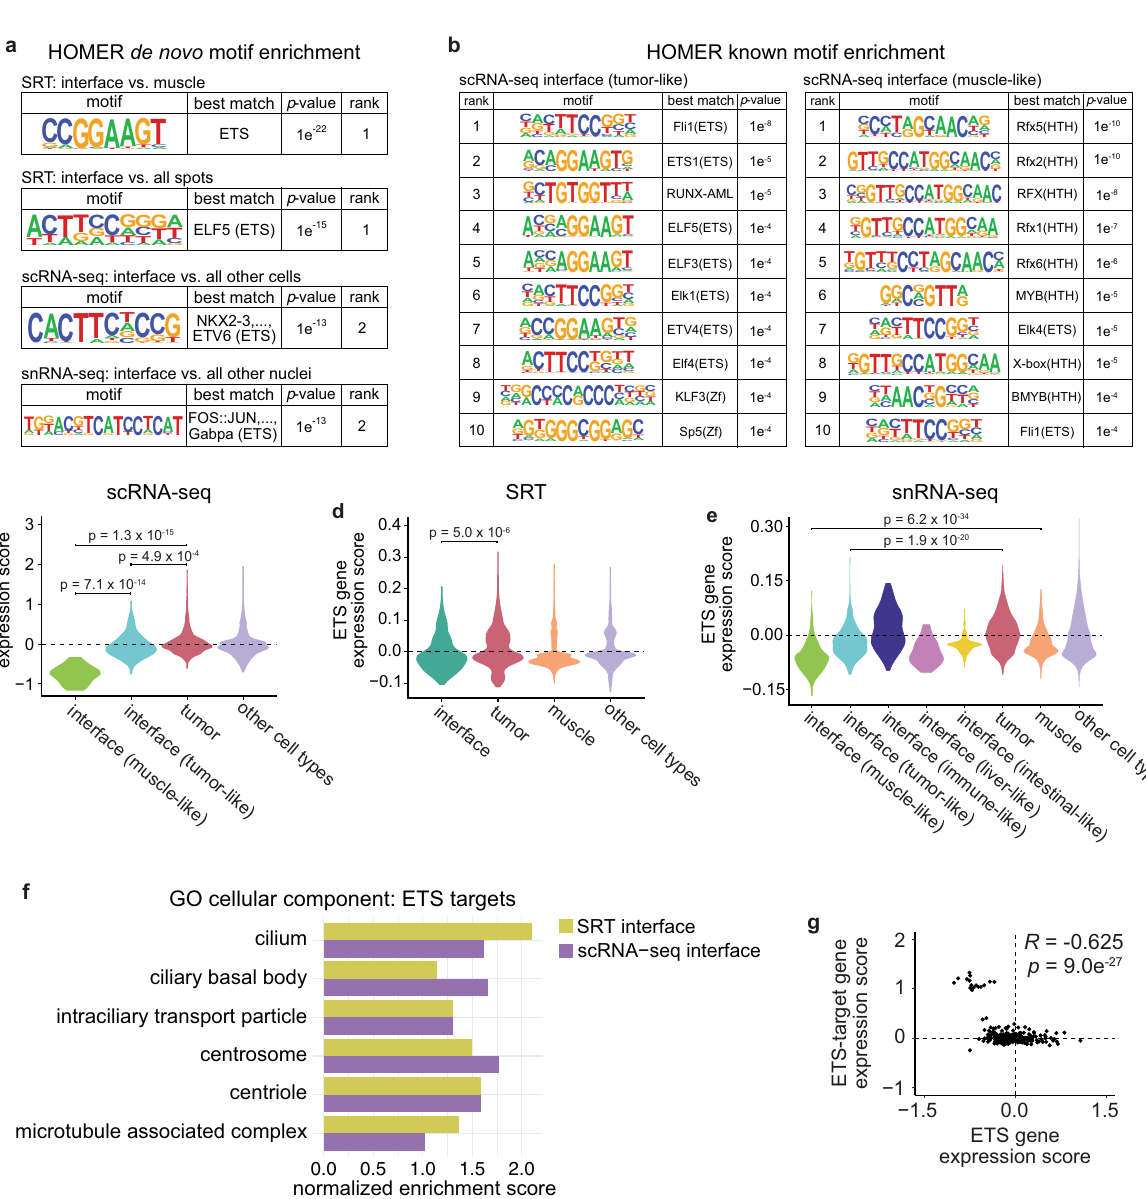
Fig. 6 ETS transcription factors may regulate cilia gene expression at the interface. a Results from HOMER de novo motif analysis of differentially expressed genes in the SRT, scRNA-seq, and snRNA-seq interface clusters. b Top ten enriched motifs from HOMER known motif analysis of the scRNA- seq tumor-like (left) and muscle-like (right) interface cell states. a , b p -values calculated using the hypergeometric test (one-tailed). c – e Relative expression of zebra fi sh ETS genes across the clusters in the scRNA-seq ( c ), SRT ( d ), and snRNA-seq ( e ) datasets. p -values are noted (Wilcoxon rank sum test, two-sided, with Bonferroni ’ s correction). f Normalized enrichment score of cilia-related pathways enriched in ETS-target genes within the SRT and scRNA-seq interface clusters. g Scatter plot comparing ETS gene expression scores per cell and ETS-target gene expression scores per cell in the scRNA- seq interface cluster. Pearson ’ s correlation coef fi cient ( R ) and p -value of correlation (two-sided) is indicated.